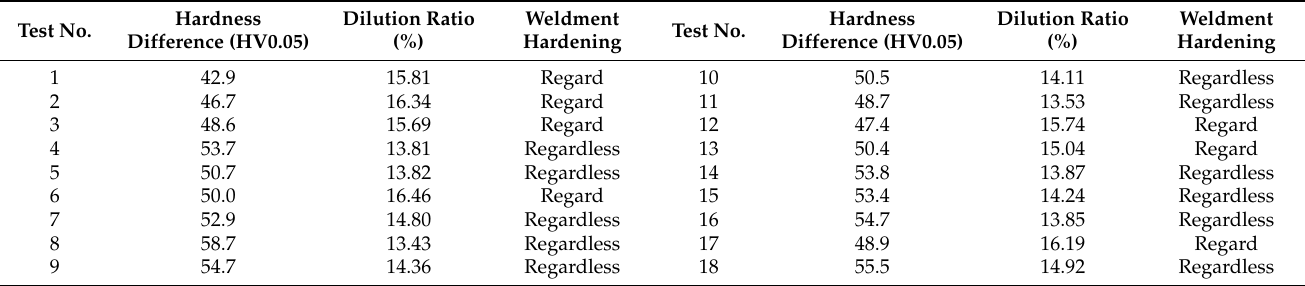
Table 8. Weldment hardening data for discriminant analysis in flux cored arc welding.